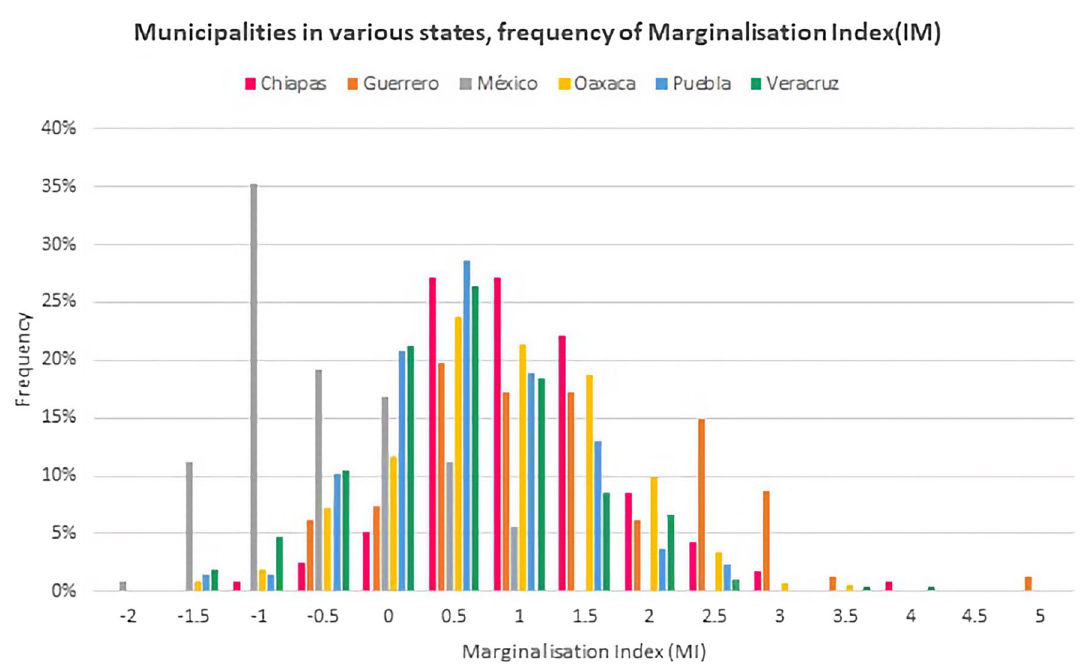
Fig. 10 Frequency of Marginalisation Index (IM) for municipalities in several Mexican States with high poverty